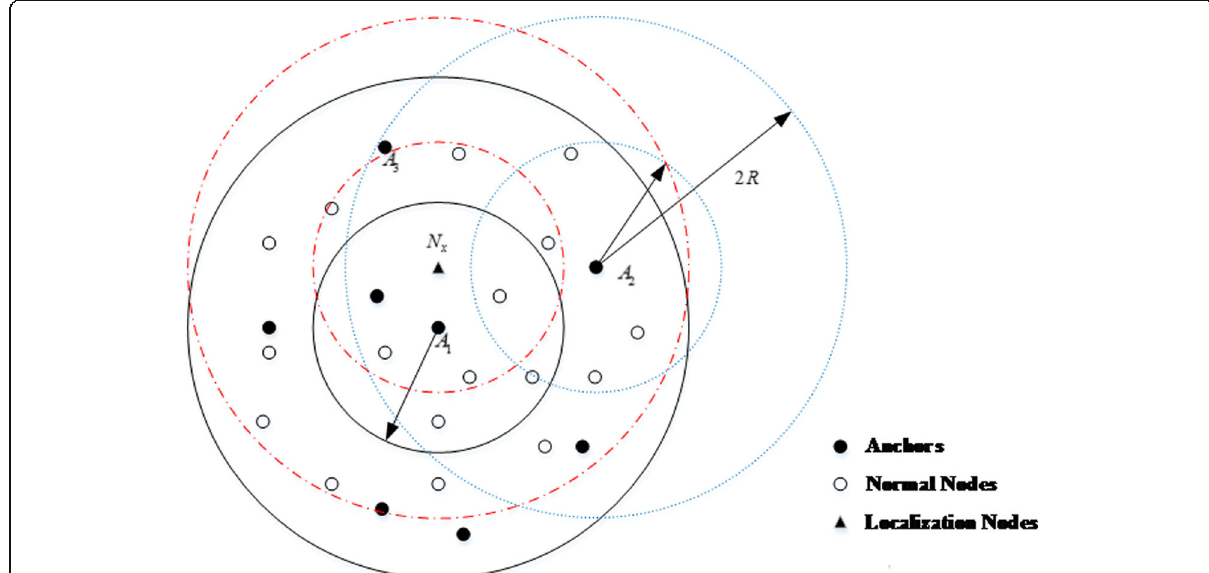
Fig. 2 The establishment of IMDV-hop scheme. N x is the unknown node and A i is the